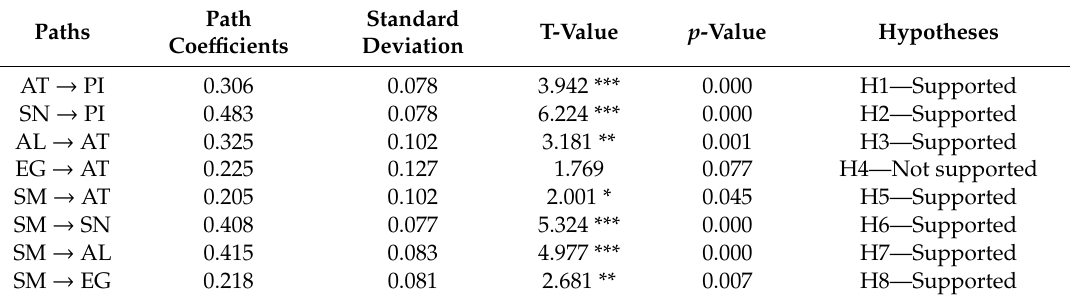
Table 5. The path coe ffi cients of the structural equation